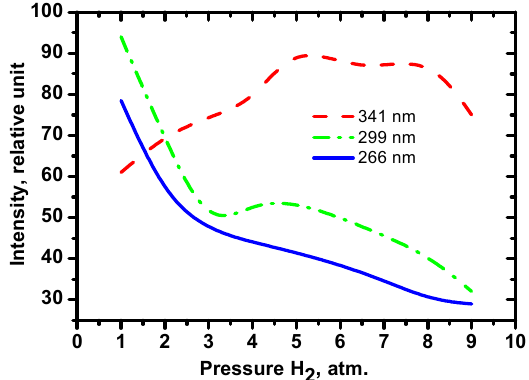
Figure 3. Relative intensities of pumping (266 nm), the first (299 nm) and the second (341 nm) Stokes conversion components of SRS conversion as functions of hydrogen pressure.